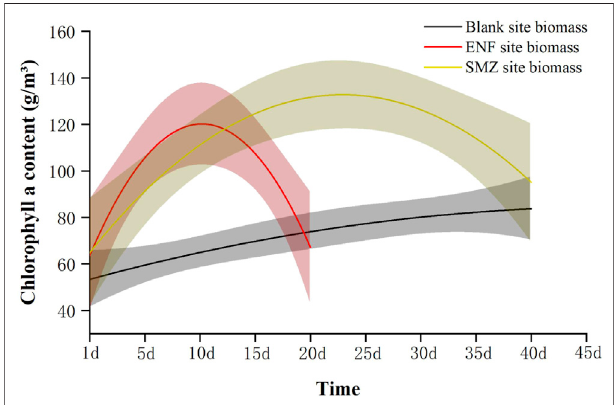
FIGURE 3 | Effects of sulfamethoxazole and enro fl oxacinon on phytoplankton biomass.